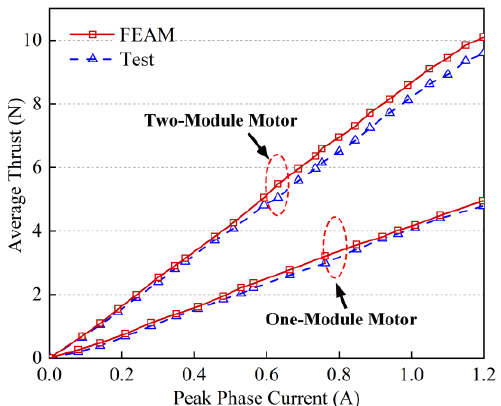
Figure 8. Average thrust comparison of the one-module motor and two-module motor varying with peak phase current.